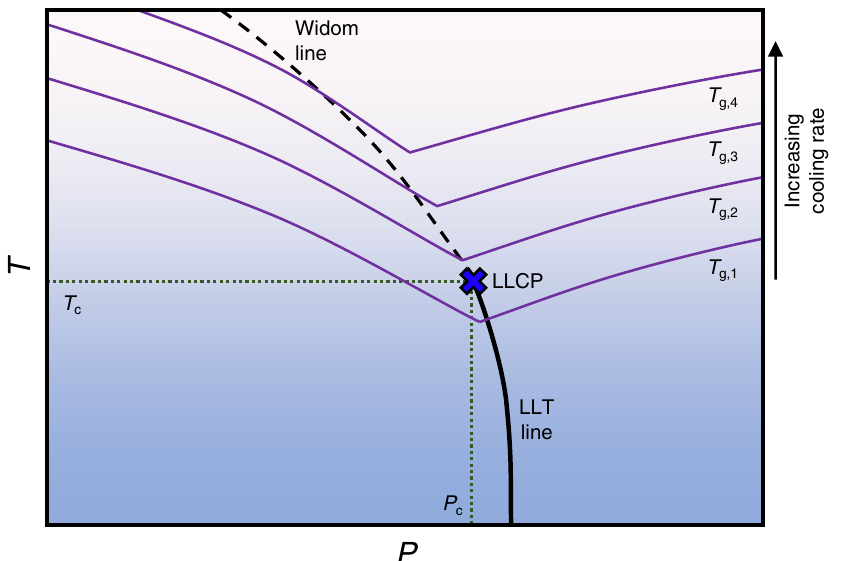
Fig. 4 Schematic metastable and glassy water phase diagram in the temperature – pressure plane. Purple lines represent the loci of glass transition temperature ( T g ) vs. pressure ( P ) for different cooling rates. Black solid and dashed lines represent the LLT and Widom lines, respectively. The LLCP is represented with a blue